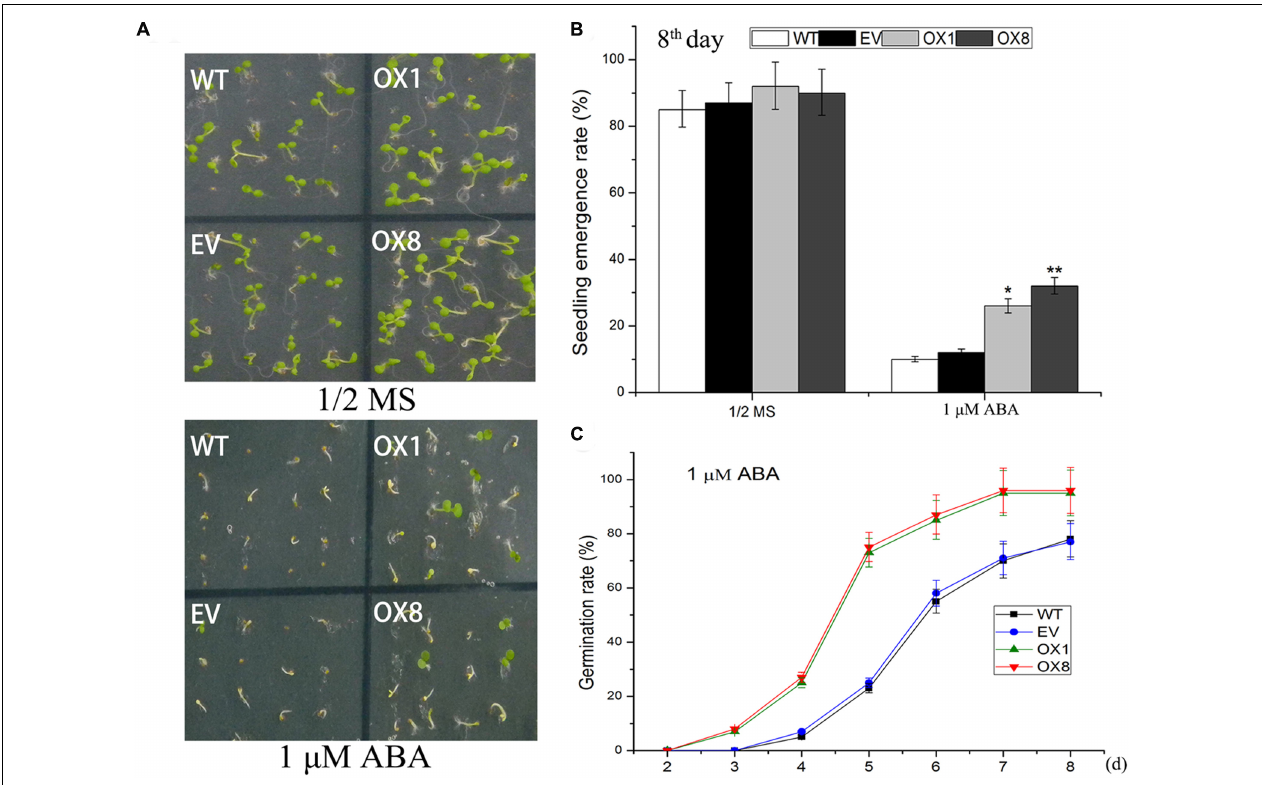
FIGURE 4 | Response of TaNAC2D -OX plants to exogenous ABA. (A) Germination performance of WT, EV, and OXs grown for 8 days on 1/2 MS medium containing 1 µ M ABA. (B) Seedlings emergence rate of WT, EV, and OXs. (C) Percent germination of WT, EV, and OXs. Data in (B,C) are means ± SE of three biological replicates ( n = 40 to 50 seeds per genotype per experiment). Asterisks indicate significant differences from WT ( ∗ P < 0.05, ∗∗ P <